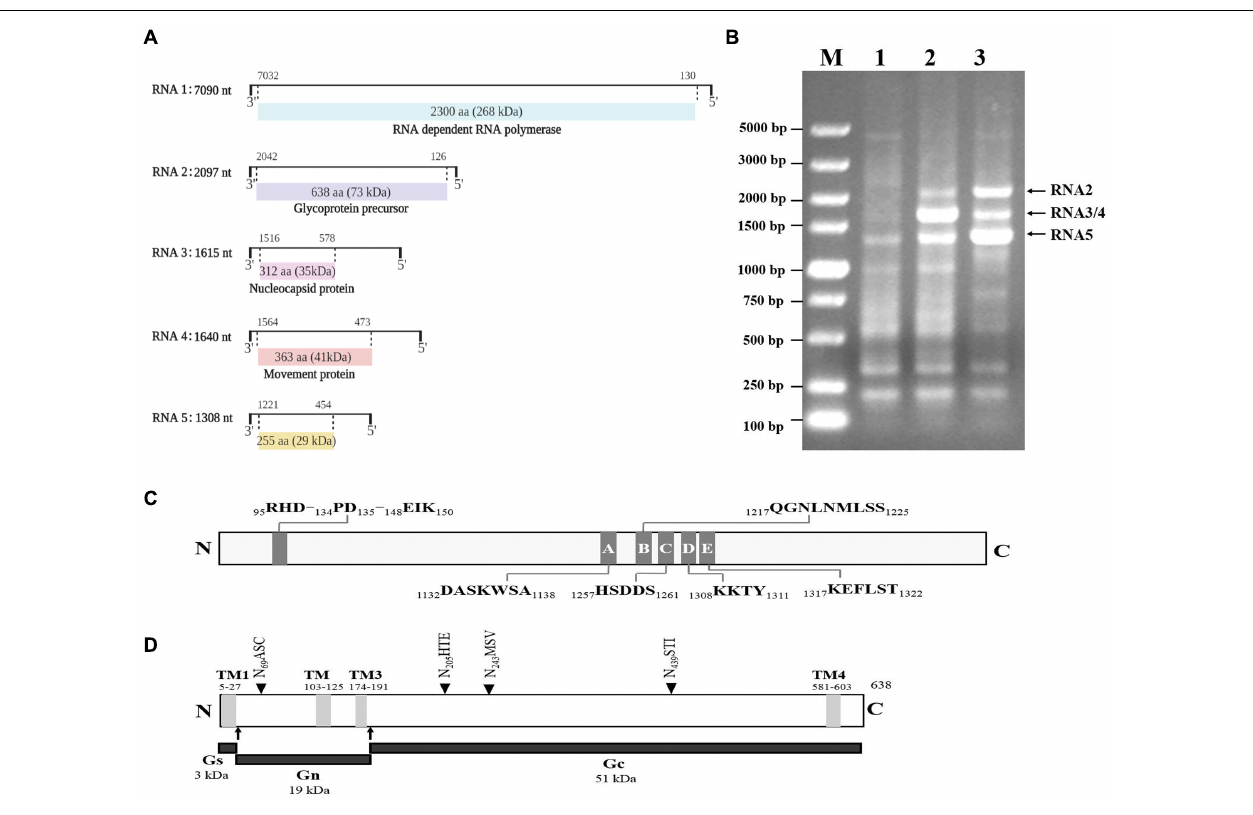
FIGURE 2 | Genomic organization of grapevine emaravirus A (GEVA) (schematic) (A) . The nucleotide (nt) length of each RNA is represented as a black line. Black boxes at the end of each line indicate the 13 nt conserved at RNA termini. The expression product of each RNA is shown as a box, with the amino acid (aa) length, estimated molecular mass (kDa) and putative protein indicated. (B) Reverse transcription polymerase chain reaction (RT-PCR) of full-length RNA genomic segments of GEVA. Lane 1, asymptomatic leaves of a “Shennong Jinhuanghou” (SJ) grapevine not infected by GEVA; lane 2, symptomatic leaves of a SJ grapevine infected by GEVA, with RT using the 3C primer; lane 3, symptomatic leaves of a SJ grapevine infected by GEVA, with RT using the 3 (cid:48) -CDS primer provided with the RACE kit (TaKaRa Biotechnology, Shiga, Japan); M, DNA molecular mass marker with sizes (bp) indicated on the left. (C) Conserved endonuclease domain and motifs A–E